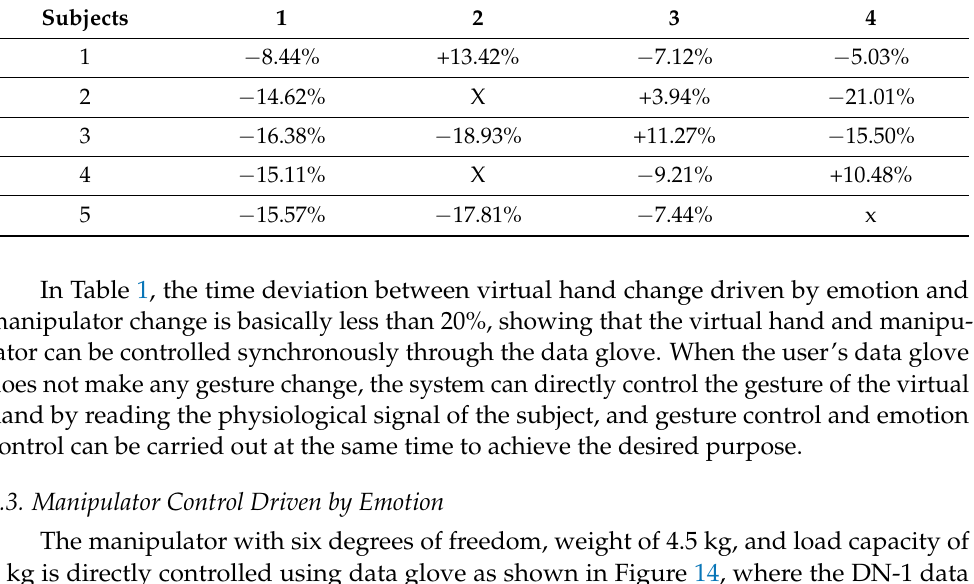
Table 1. The time deviation between virtual hand change driven by emotion and manipulator change.